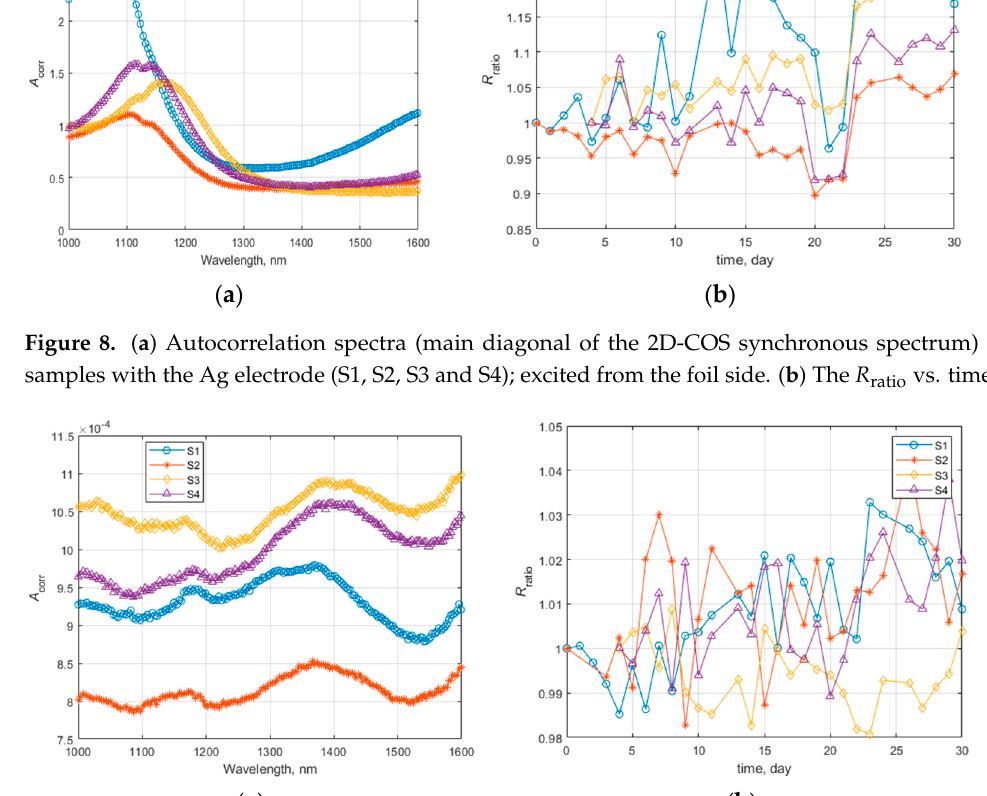
Figure 8. ( a ) Autocorrelation spectra (main diagonal of the 2D-COS synchronous spectrum) of sam-